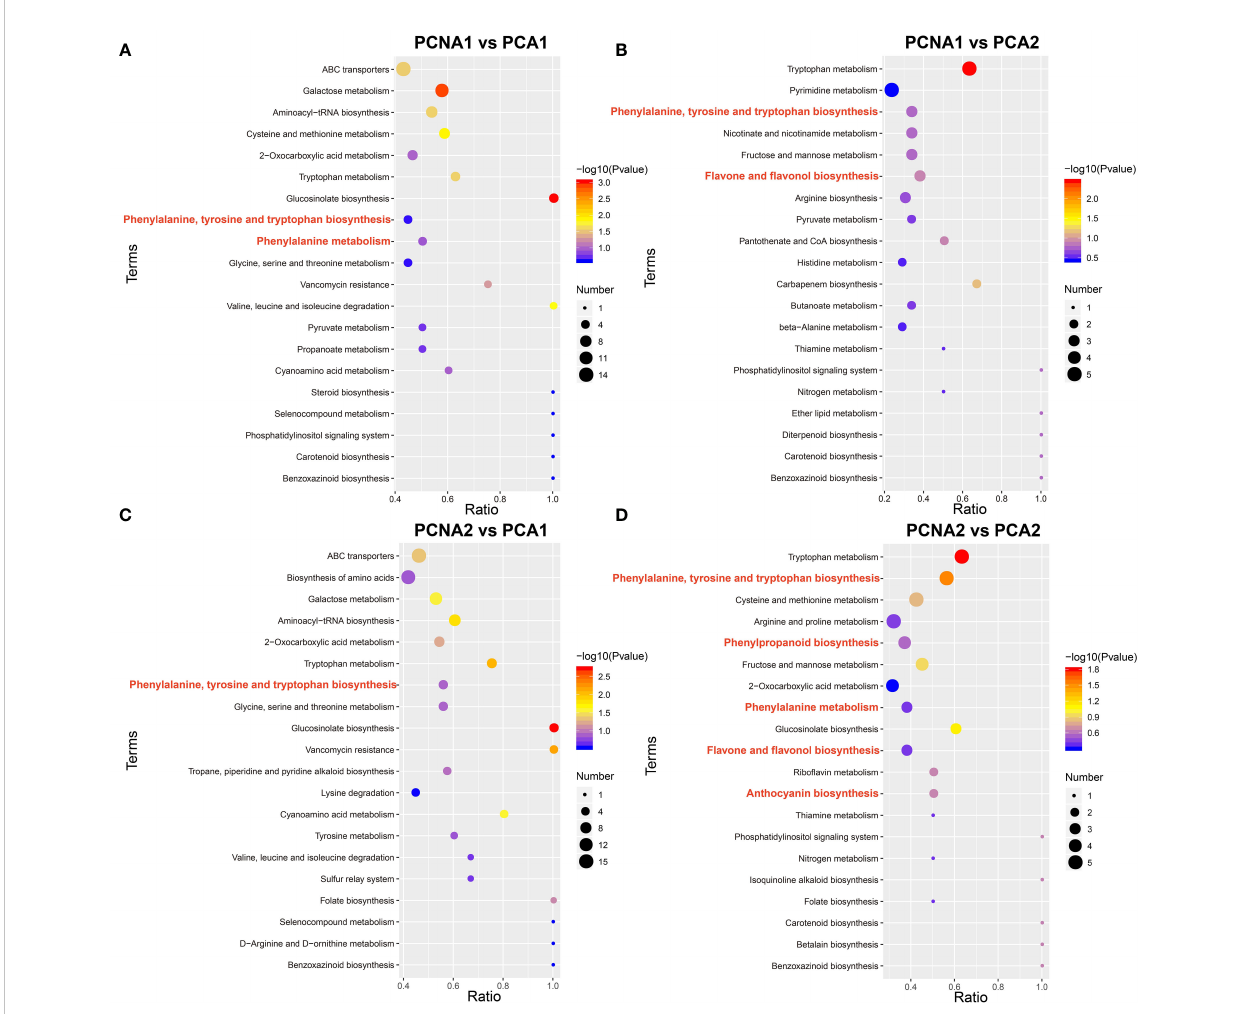
FIGURE 1 Comparison of metabolites between mature PCNA and PCA persimmon fruit. Scatter plot showing KEGG enrichment of DEGs between the PCNA and PCA groups. (A) PCNA1 vs. PCA1 group. (B) PCNA1 vs. PCA2 group. (C) PCNA2 vs. PCA1 group. (D) PCNA2 vs. PCA2